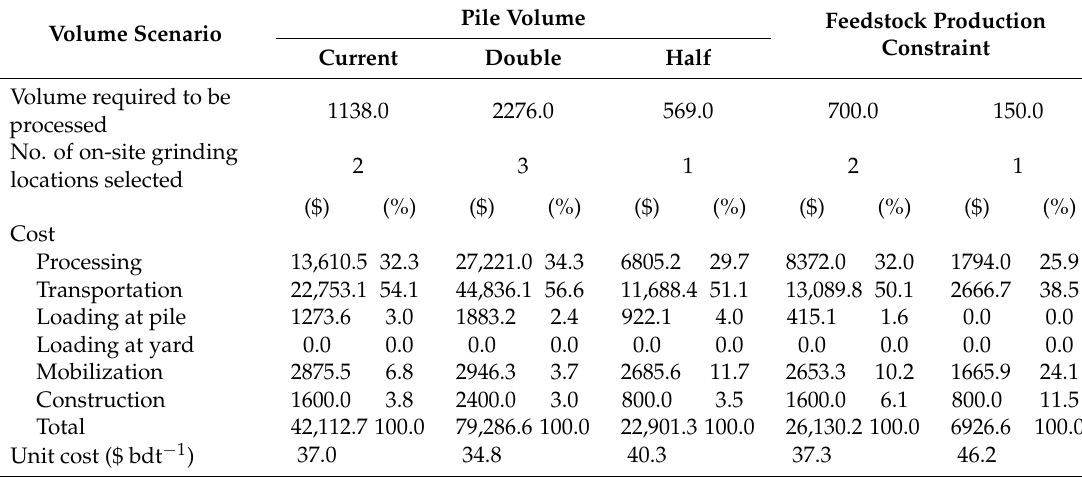
Table 7. Results of a cost analysis for different volume quantity